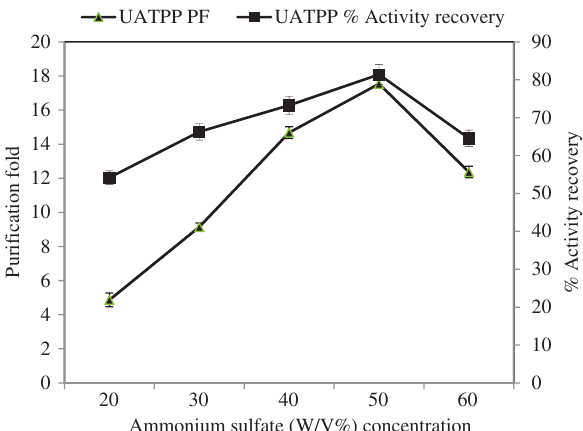
Figure 2: Effect of ammonium sulfate saturation on ultrasound assisted three phase partitioning (UATPP) of